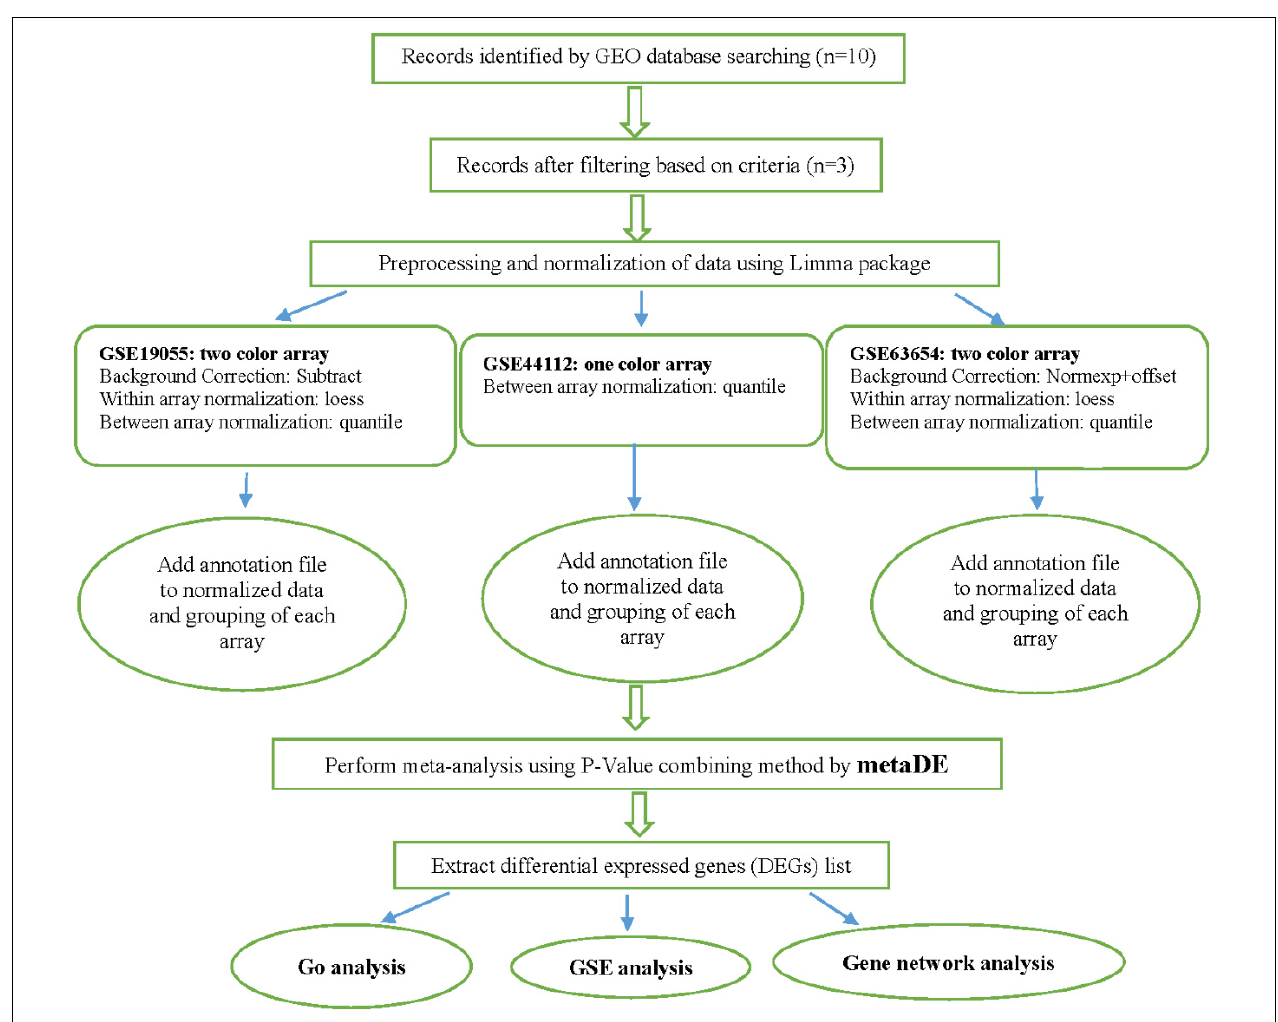
FIGURE 1 | Flowchart of the performed meta-analysis of milk production in this